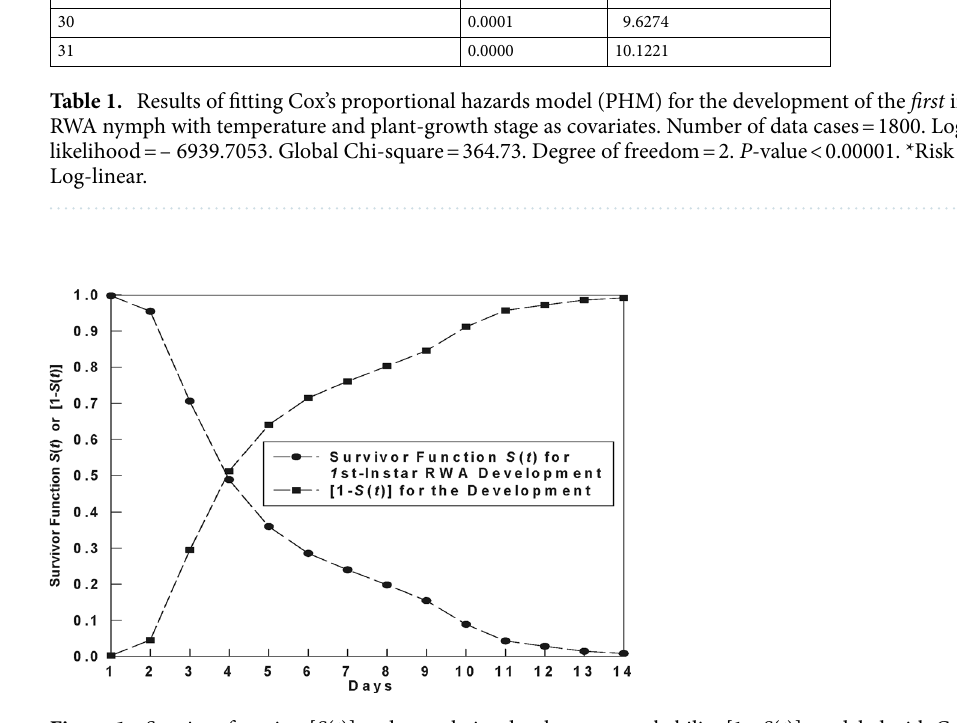
Figure 1. Survivor function [ S ( t )] and cumulative development probability [1 − S ( t )] modeled with Cox PHM for the development of the first -instar RWA